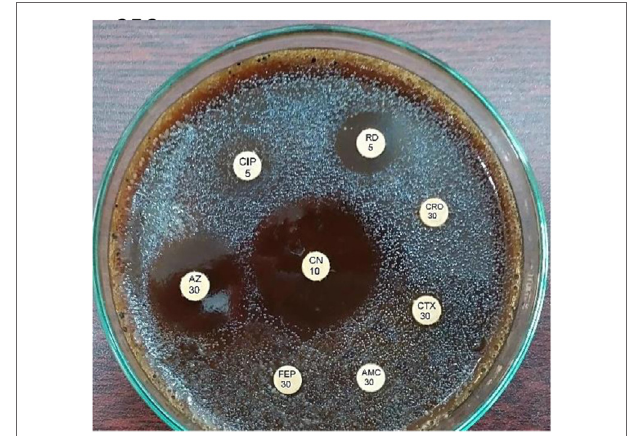
FIGURe 1 | Susceptibility test using Kirby–Bauer disk diffusion